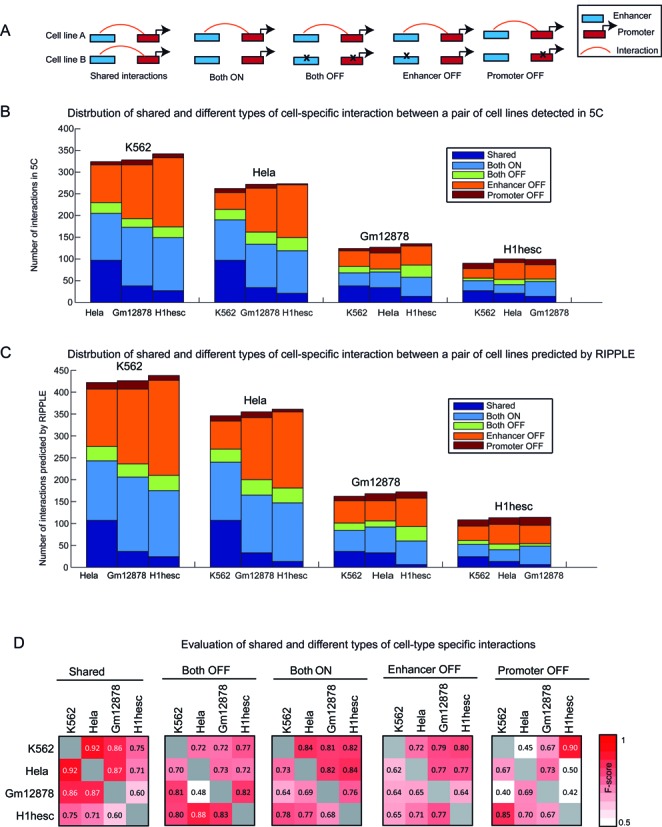
Characterization of different types of cell line-specific interactions. (A) Shown are the different statuses of an interaction comparing a pair of cell lines, (A) and (B). These statuses can be, ‘shared’, or cell-line specific. Cell-line specific interactions in turn can be grouped into ‘Both OFF’, ‘Enhancer OFF’, ‘Promoter ON’ and ‘Both ON’. (B) Shown are the relative proportions of the different interaction types in the 5C data when comparing each cell line to one of the other three cell lines. (C) Shown are the relative proportions of the different interaction types in the RIPPLE predicted interaction networks. The relative proportions of different types of interactions are similar between RIPPLE and 5C. (D) Shown is the agreement (as measured by F-score values) of interactions in different categories predicted based on RIPPLE and based on 5C. The higher the F-score the greater the agreement.